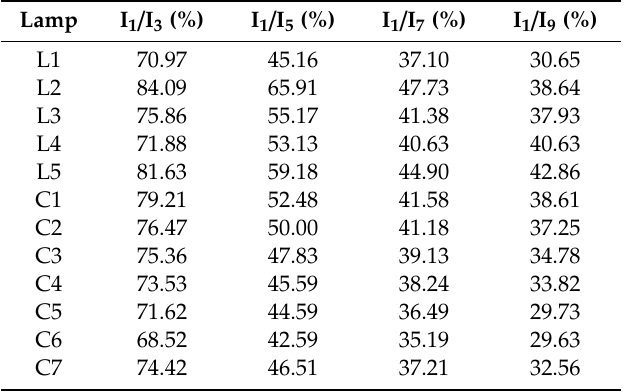
Table 6. Harmonic currents expressed as a percentage of the fundamental current.